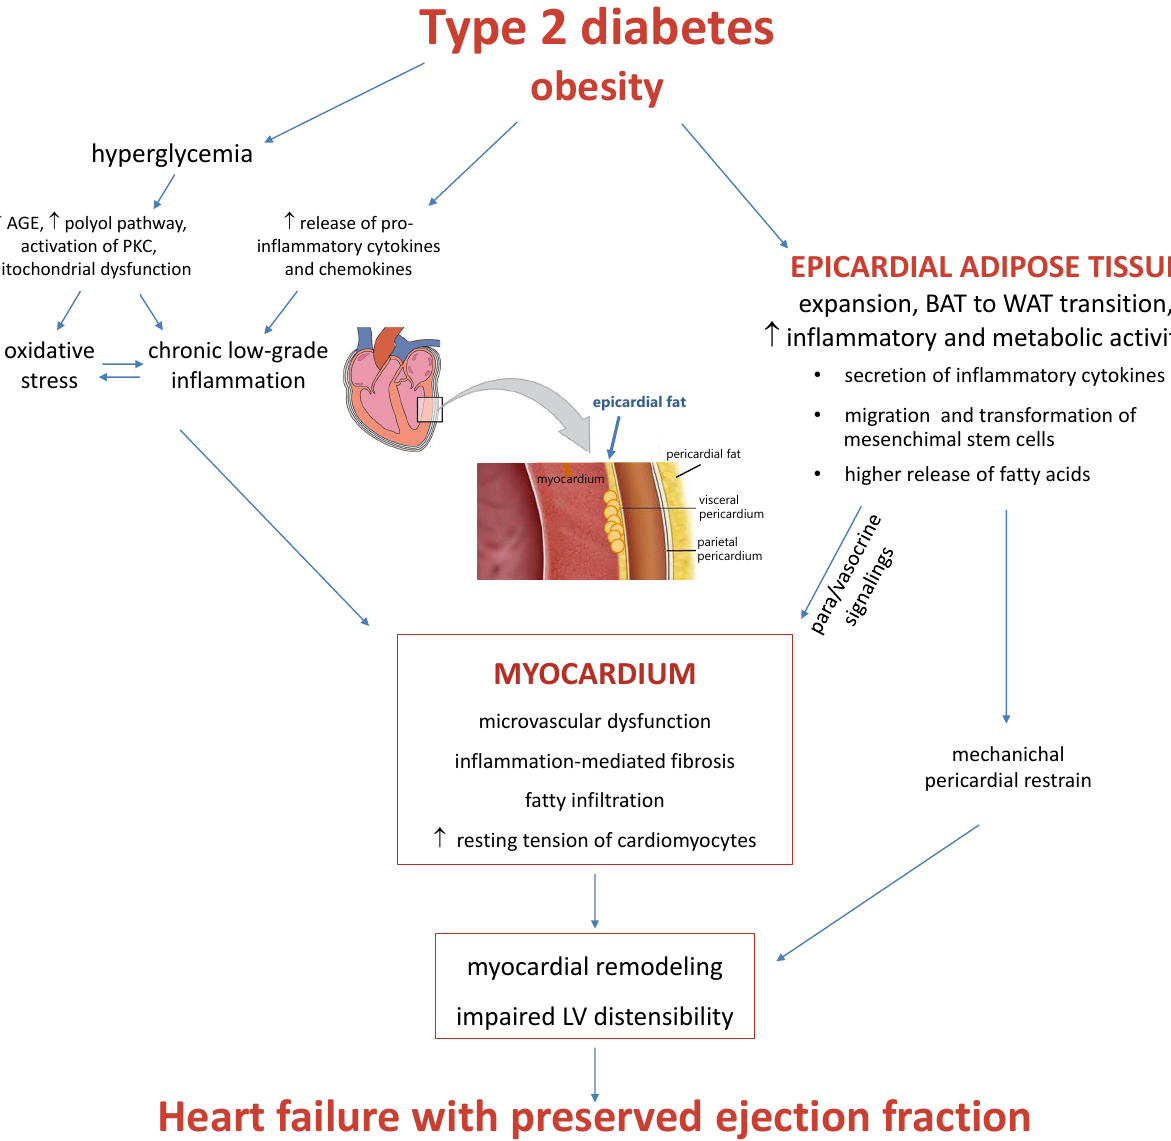
Figure 1. Two Inflammatory and microvascular mechanisms. Mechanical and Metabolic